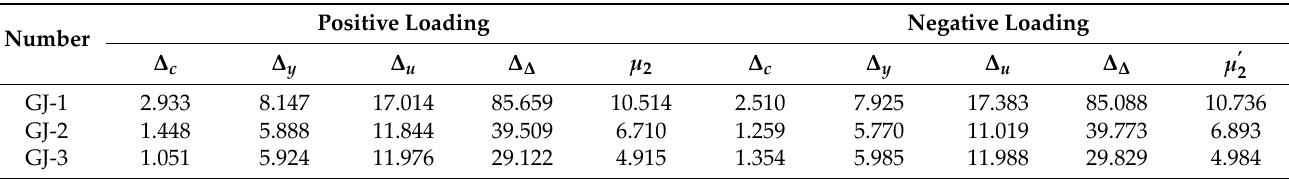
Table 2. Displacements and ductile factor of three